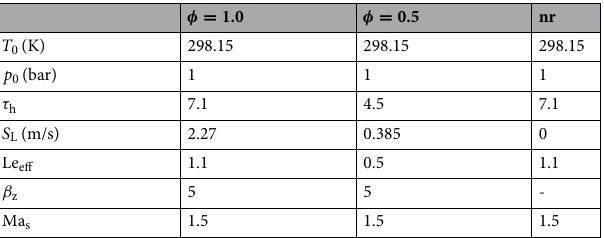
Table 1. Simulation parameters for the stoichiometric (equivalence ratio φ = 1.0 ), lean ( φ = 0.5 )